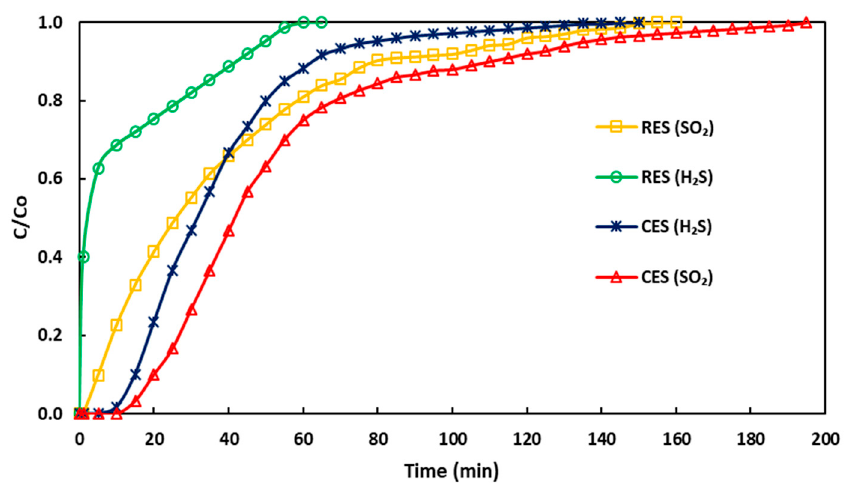
Figure 8. Breakthrough curves of SO 2 and H 2 S with 40% relative humidity.